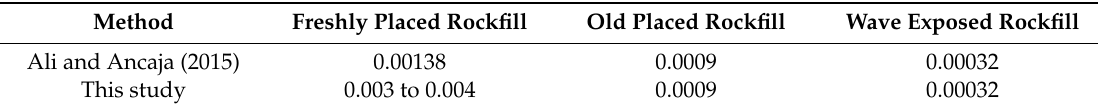
Table 8. Summary of creep index values based on back analyses of [3] and this study. Method Freshly Placed Rockfill Old Placed Rockfill Wave Exposed